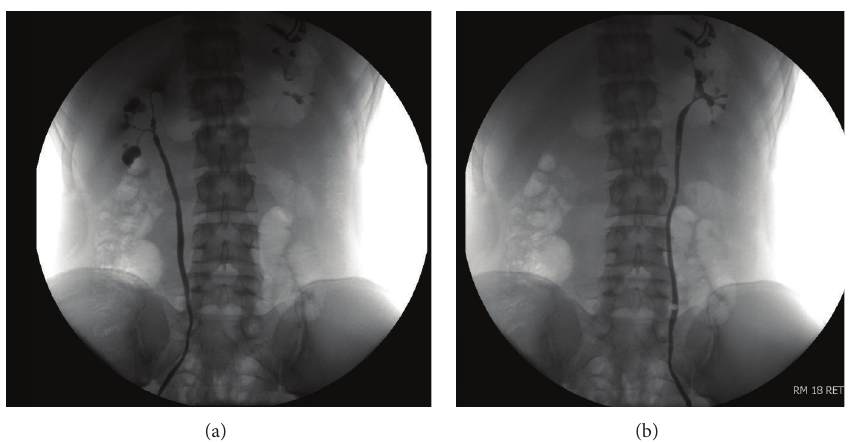
Figure 2: Retrograde pyelogram of right kidney (a) showing stenotic infundibulae, the absence of a renal pelvis, and dilated calyces. Left kidney (b) has a normal collecting